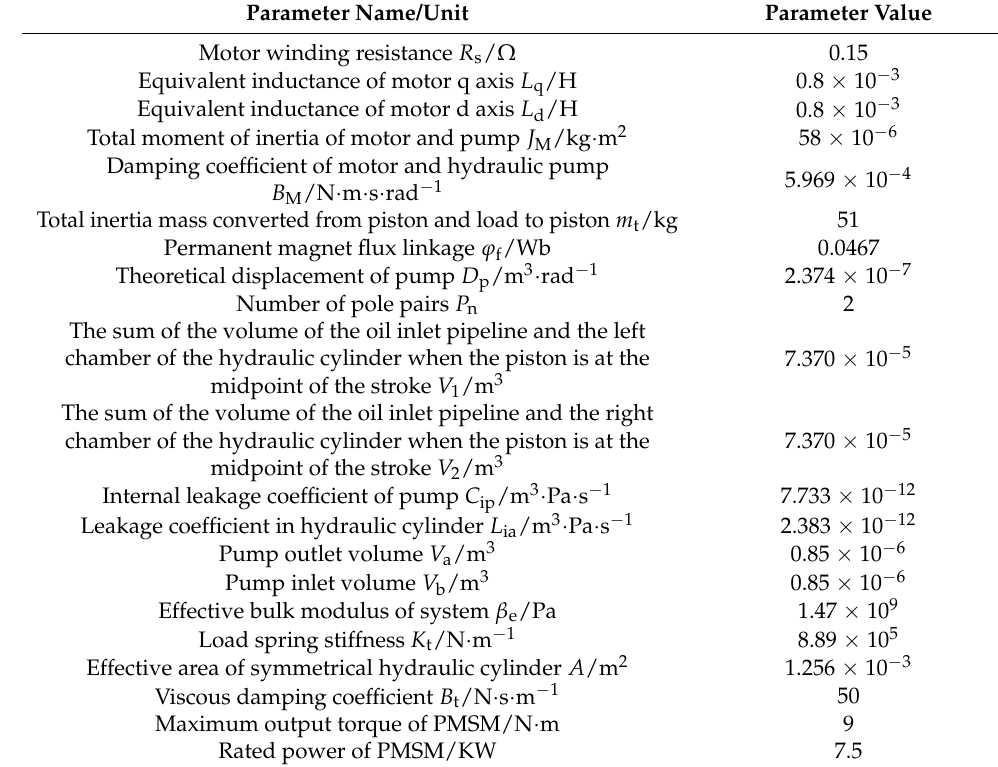
Table 3. Double redundancy EHA system